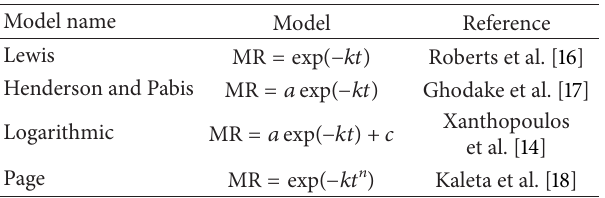
Table 1: Mathematical models given by various authors for drying